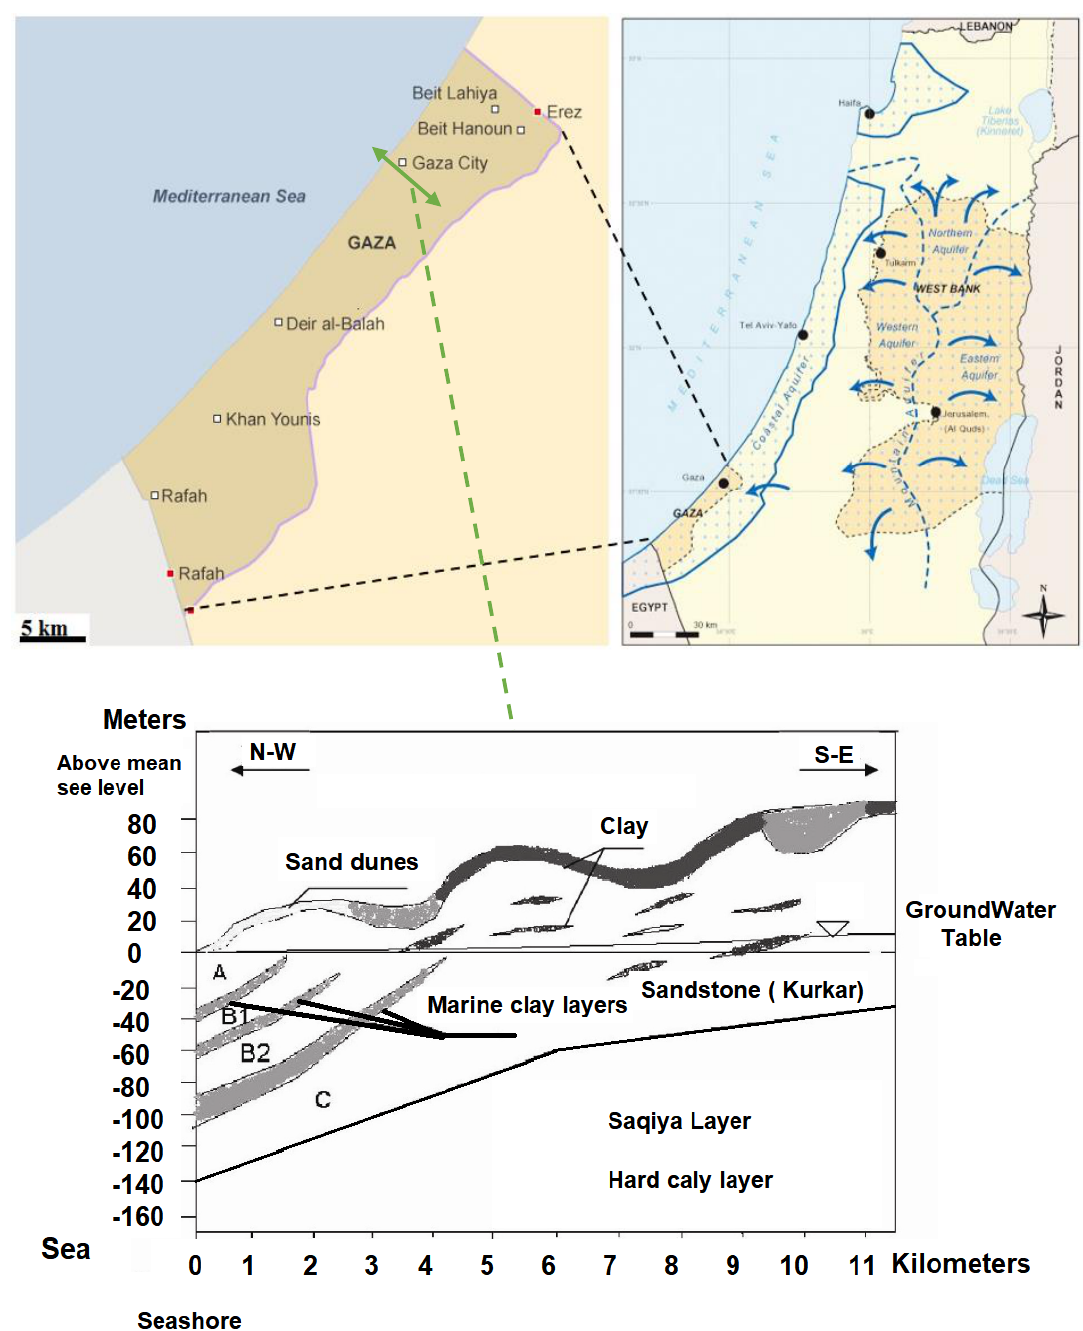
Figure 1. Regional and location map of Gaza Strip and the coastal aquifer and cross-section of the coastal aquifer at the middle area of GCA.